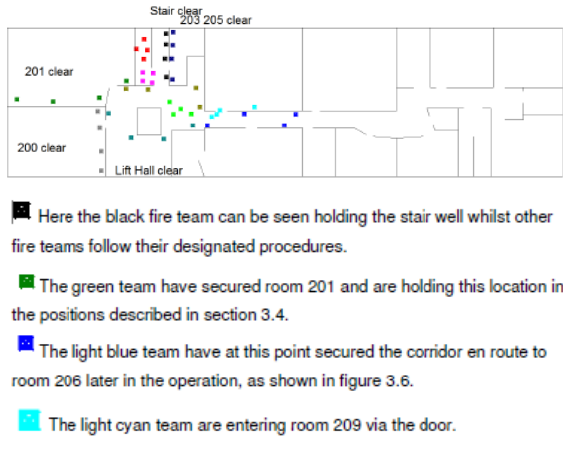
Figure 5. Partway through the operation.